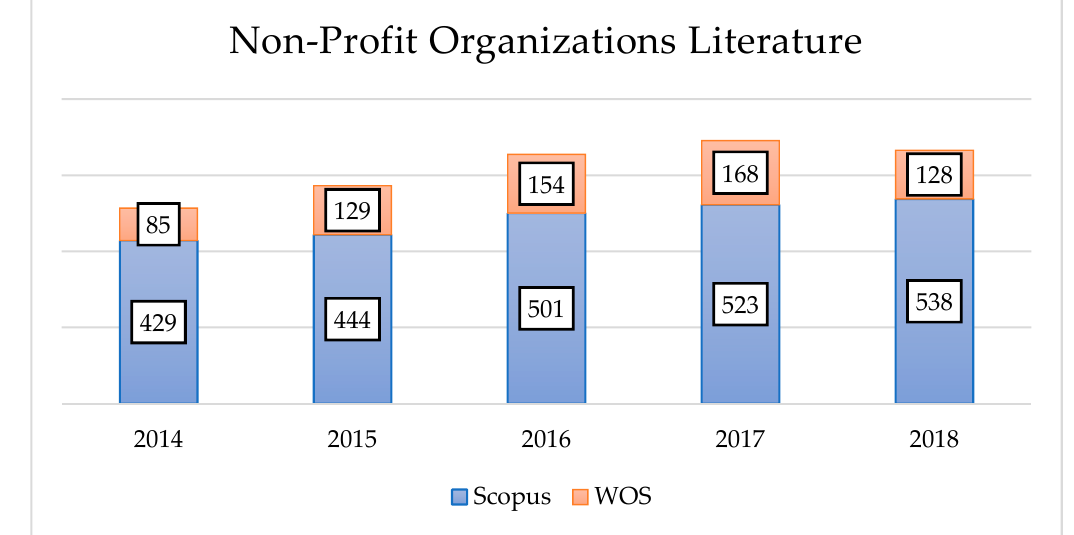
Figure 1. Documents related to non-profit organizations (2014–2018). Source: Query on Scopus and Web of Science (WOS) (2019).